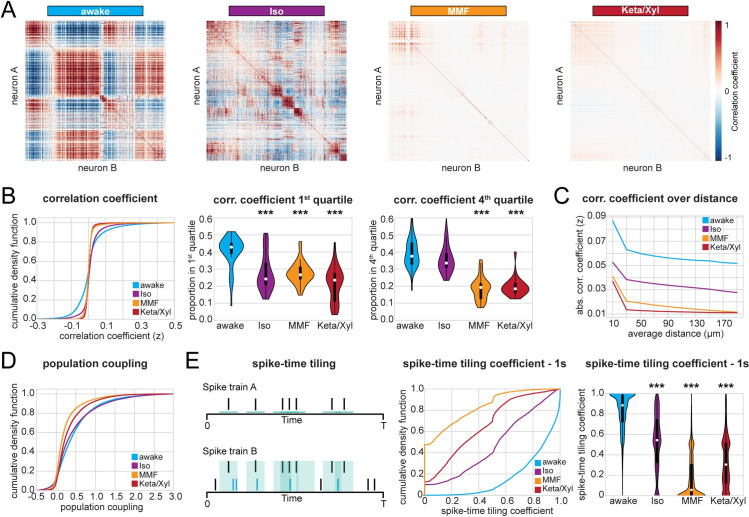
Correlation analysis of CA1 calcium activity and SUA shows decorrelation under anesthesia.(A) Heat maps displaying representative correlation matrices of calcium activity between pairs of neurons during wakefulness and the 3 different anesthetic conditions in the same animal. Matrices are sorted by similarity. (B) Left: Line plot displaying cumulative distribution of Fisher-corrected Pearson correlation coefficients between pairs of neurons (calcium imaging). Center: violin plot displaying the proportion of pairs found in the first (most negative) and fourth (most positive) quartile of the distribution. (C) Line plot displaying the absolute pairwise correlation coefficients over distance (calcium imaging, 25-micrometer bins). (D) Line plot displaying the cumulative distribution of population coupling (calcium imaging). (E) Quantification of correlation between pairs of extracellularly recorded single units using the STTC. Left: Schematic illustration of the STTC quantification. Center: cumulative distribution of the STTC with a 1,000-ms integration window. Right: violin plot quantifying the STTC. In violin plots, white dots indicate median, and vertical thick and thin lines indicate first to third quartile and interquartile range, respectively. Asterisks in (B) and (E) indicate significant differences to wakefulness. *** p < 0.001. Note, only differences to wakefulness are indicated. For comparison between conditions, see S1 Table. All datasets of this figure can be found under https://github.com/mchini/Yang_Chini_et_al/tree/master/Stats_Dataset_(R)/datasets/Figure5_S7. Iso, isoflurane; Keta/Xyl, ketamine/xylazine; MMF, medetomidine/midazolam/fentanyl; STTC, spike time tiling coefficient; SUA, single-unit activity.